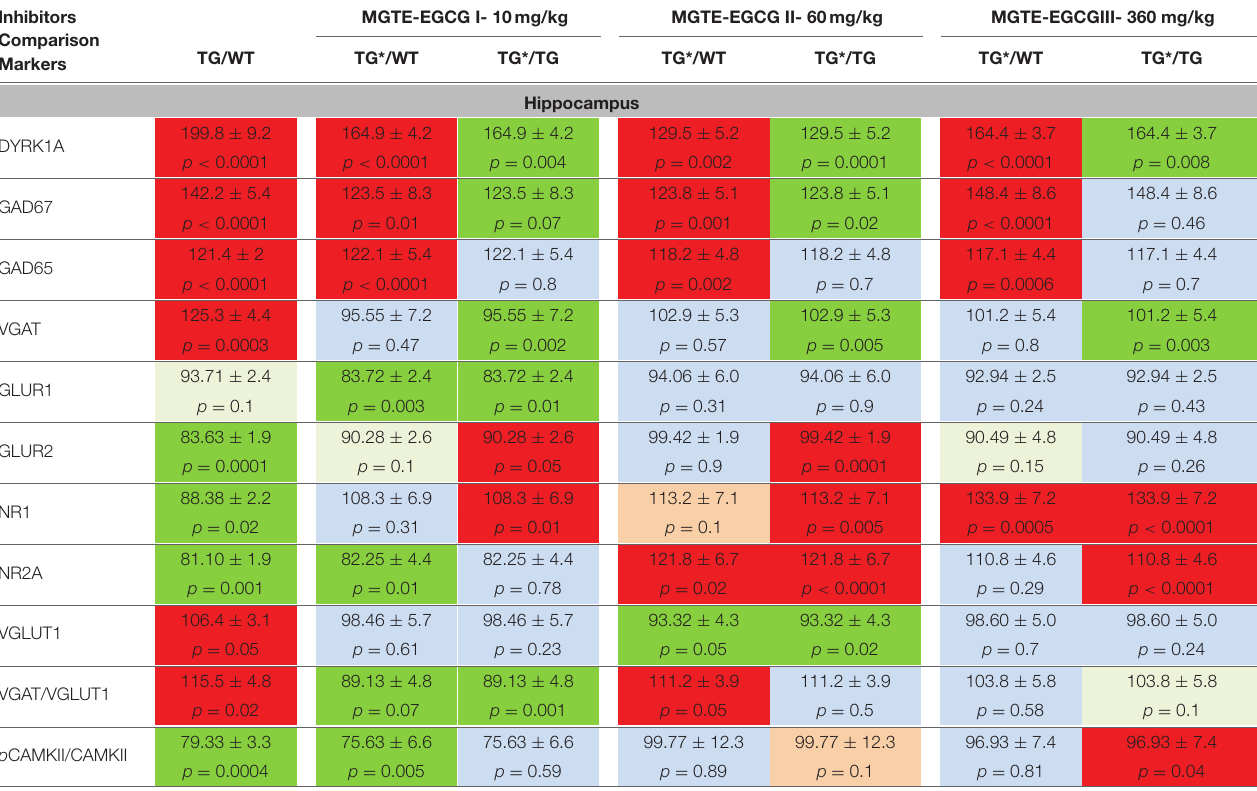
TABLE 4 | Protein levels of markers of inhibition and excitation pathways for WT and mBACtgDyrk1a (TG) in hippocampus following treatment with 3 doses of MGTE extract. Inhibitors Comparison